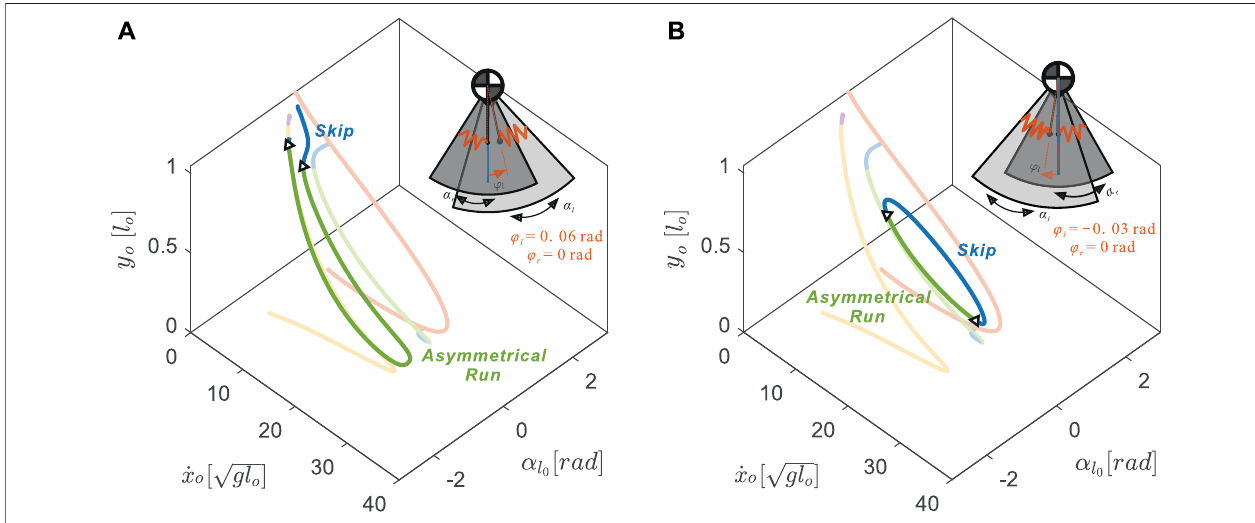
FIGURE 8 | Uncoupling the neutral leg swing angles ( φ l ≠ φ r ) resulted in drastic changes in 3D gait branch shape with respect to the nominal model (transparent curves from Figure 4 ) (A) An anterior shift, φ l =+0.06 rad, caused the asymmetrical running branch to subsume portions of the previously symmetrical running branch (yellow) (B) A posterior shift, φ l = − 0.03 rad, caused the skipping branch to subsume portions of the previously symmetrical hopping gait (red) to form a closed loop. The inset model diagrams show the range of leg rotational motions (dark grey sector for α r